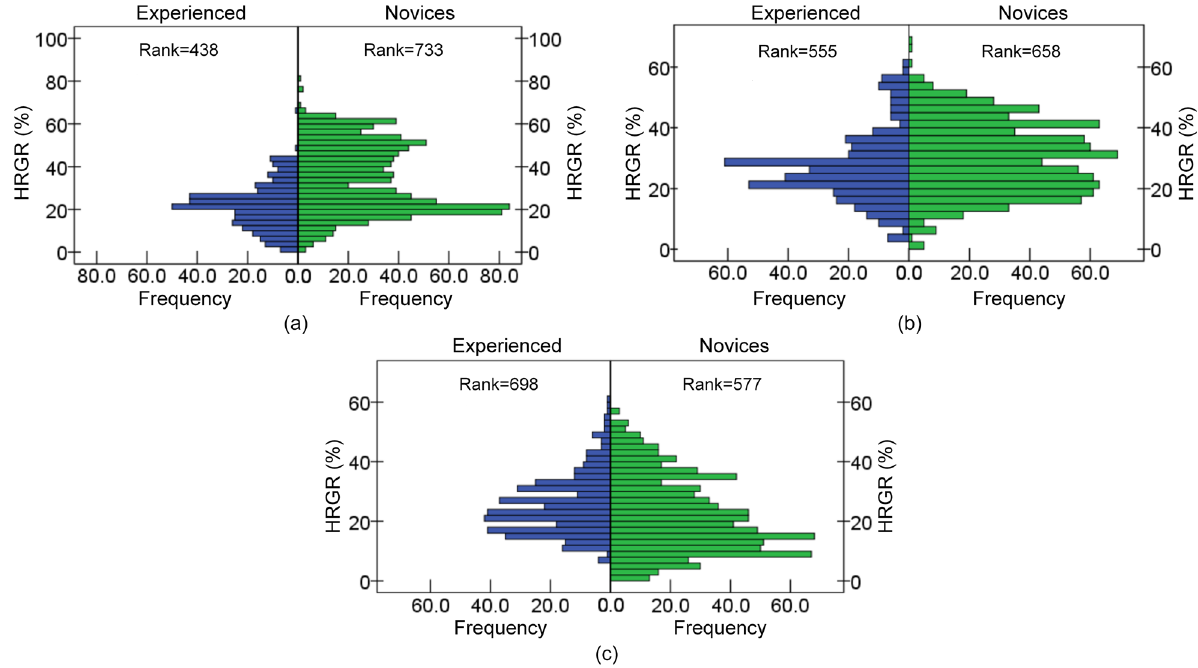
Figure 11. HRGR difference in driving experience during tasks: ( a ) Hands-free phone conversation, ( b ) slogan reading, and ( c ) chatting.